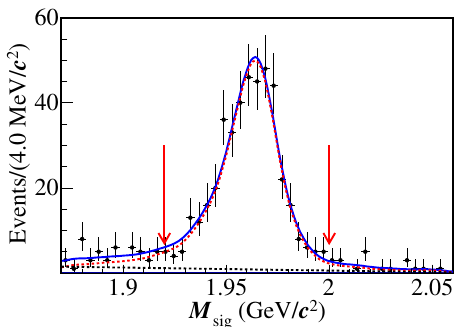
√ s = 4.178–4.226 GeV. This plot